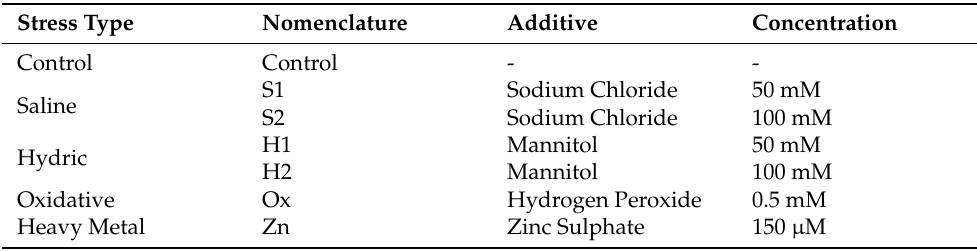
Table 2. Different conditions and additive concentrations used to induce stress during germinating Arabidopsis thaliana